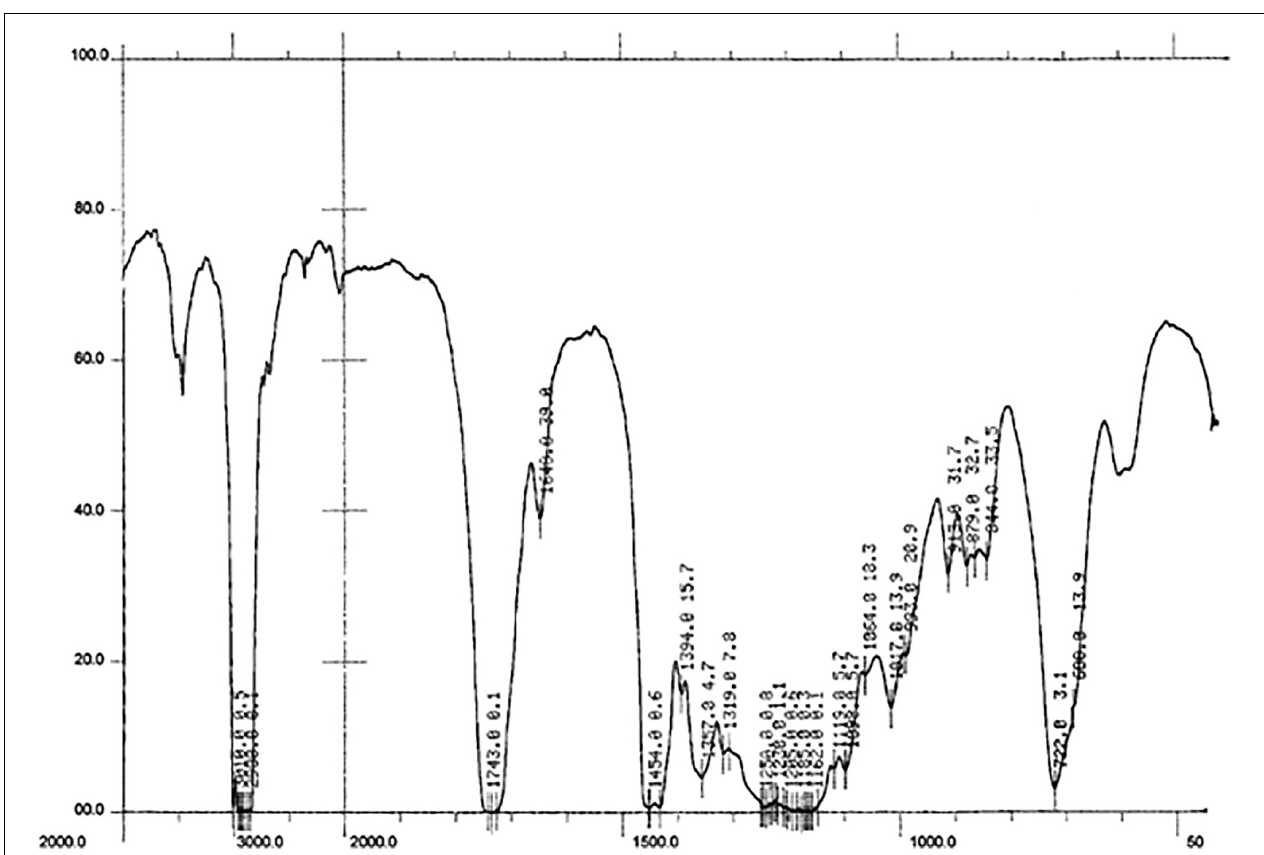
FIGURE 9 | FT-IR Spectrum Representing 12 Major Absorption Peaks in Energy Crops Cocklebur Methyl Esters.